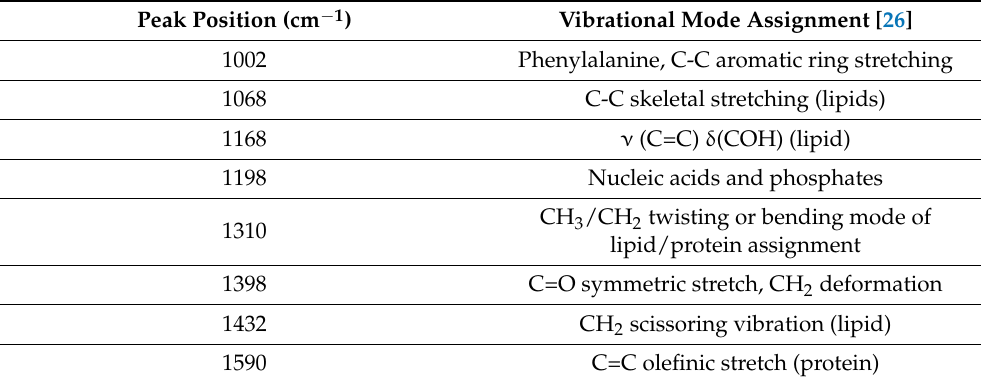
Figure 3. ( a ) Mean-centered, preprocessed mean SERS spectra and their difference for lung cancer (n = 12) and control (n = 11) groups within a wavenumber range of 735 – 1700 cm −1 . ( b ) Two-dimensional scatterplot for first two latent LVs from the PLS-DA classification model. ( c ) Receiver operating characteristics (ROC) curve demonstrating classification capability of PLS-DA classification model at different thresholds. ( d ) Variable importance in projection (VIP) score highlighting important discriminative wavenumber bands between lung cancer and control group. Table 2. Assignment of Raman wavenumbers and bands evaluated using VIP score. ν = stretch, δ = deformation [28] .